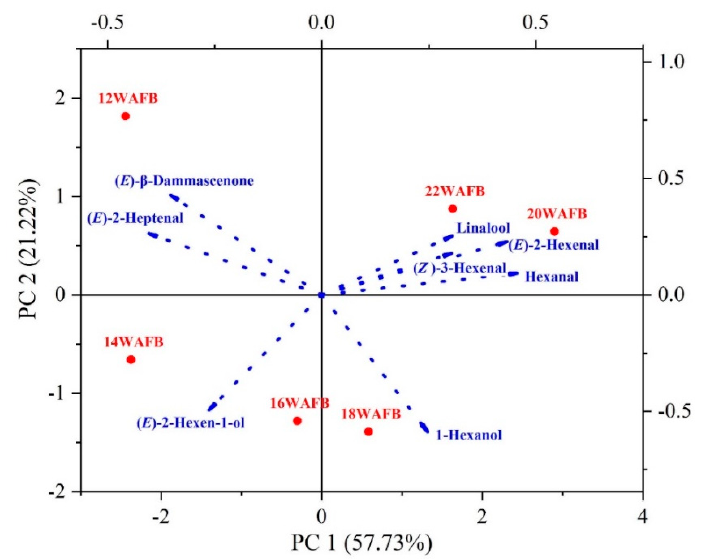
Figure 3. Biplot of principal component analysis (PCA) for active odorants in Shine Muscat grape during ripening from 12 to 22 weeks after full bloom (WAFB): Red dots represent grape samples harvested at different periods. Table 4. Changes in the sensory attribute scores of Shine Muscat grapes during